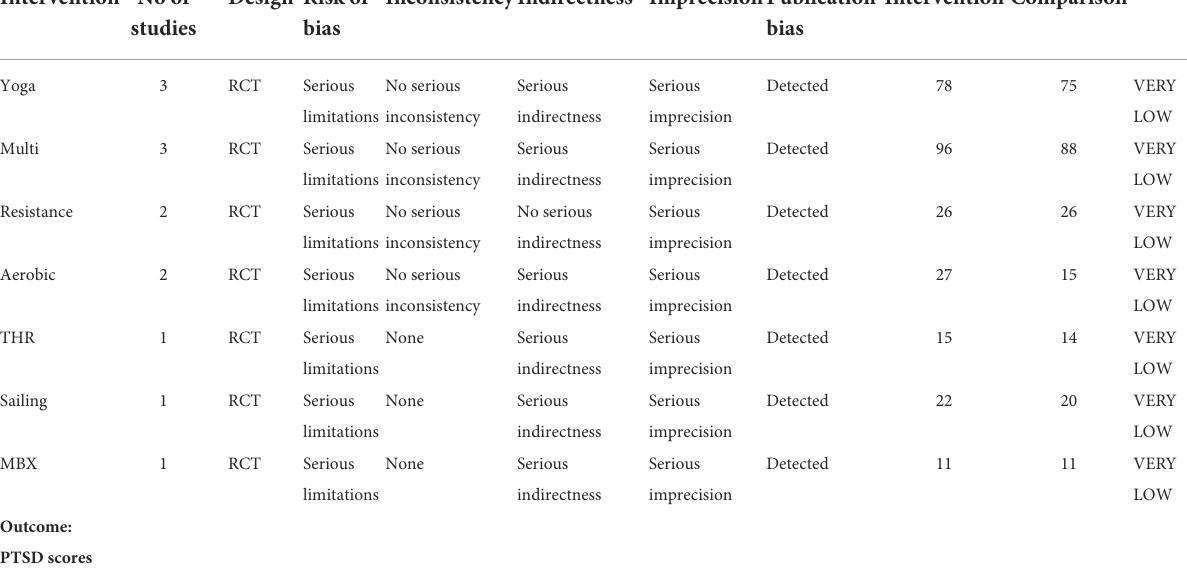
TABLE 3 GRADE rating on the level of evidence of the included